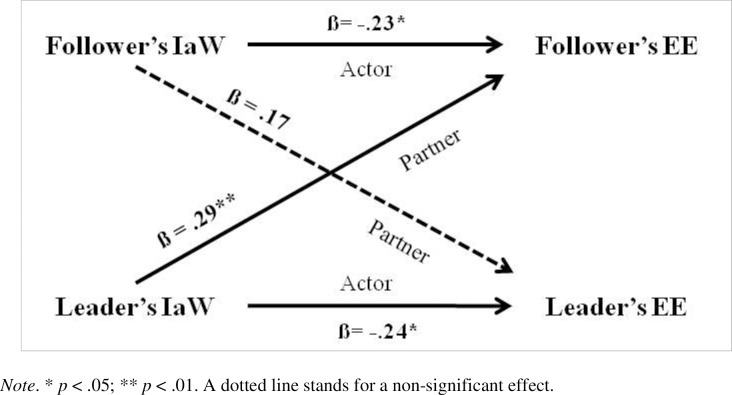
APIM with distinguishable dyads: Independence at Work (IaW) on Emotional Exhaustion (EE).